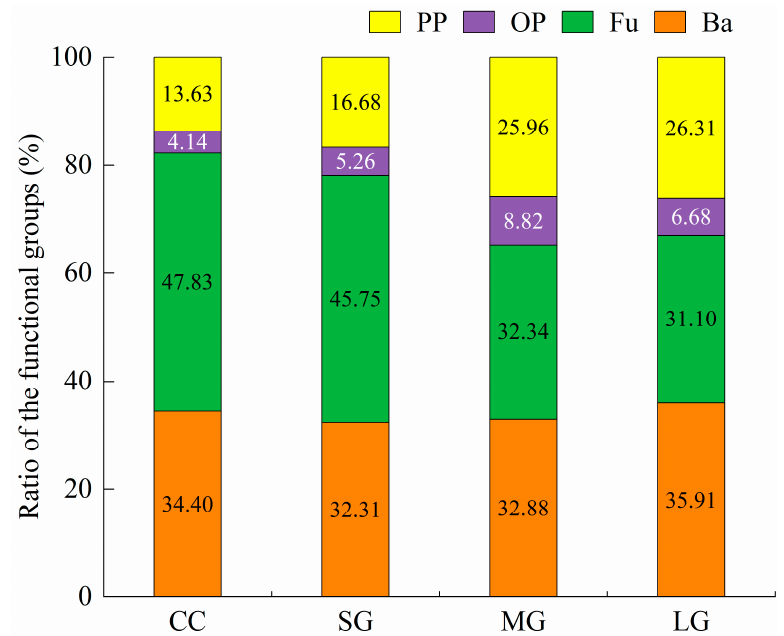
Figure 2. Ratio of the functional groups of the soil nematode community in the closed canopy and three types of forest gaps (small, medium, and large gaps). Ba, bacterivores; Fu, fungivores; OP, omnivore-predators; PP, plant parasites. CC, closed canopy; SG, small gaps; MG, medium gaps; LG, large gaps.